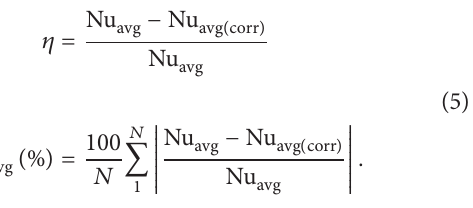
Figure 7: Variation of Nu for 𝐴 = 0.8